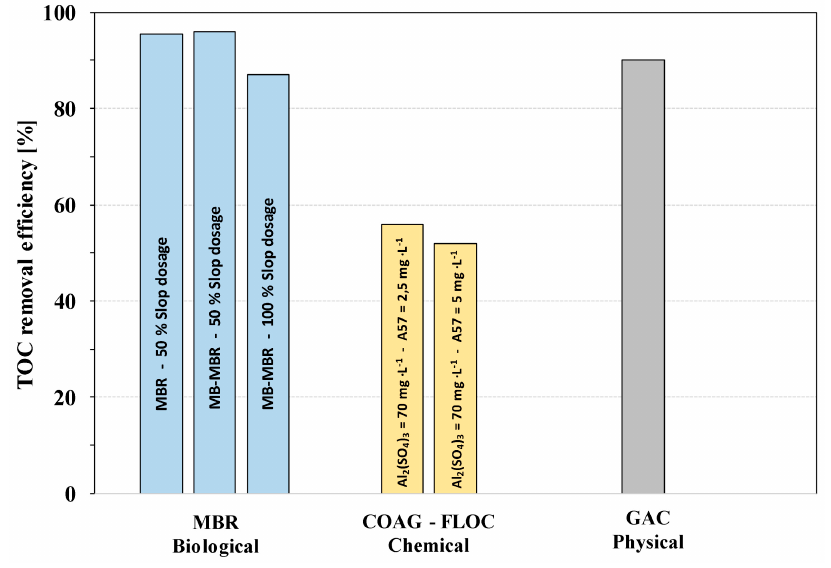
Figure 4. TOC removal efficiency of the biological (MBR), chemical (coagulation-flocculation) and Physical (GAC) treatments of slop.